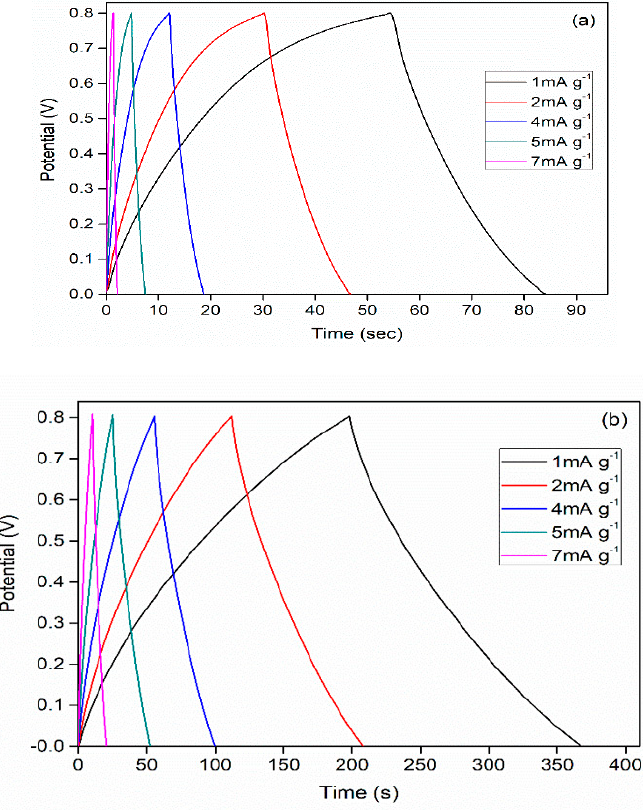
Figure 6. ( a ) Galvanostatic Charge-discharge curve of TiO 2 ( b ) Galvanostatic Charge-discharge curve of rGO/TiO 2.